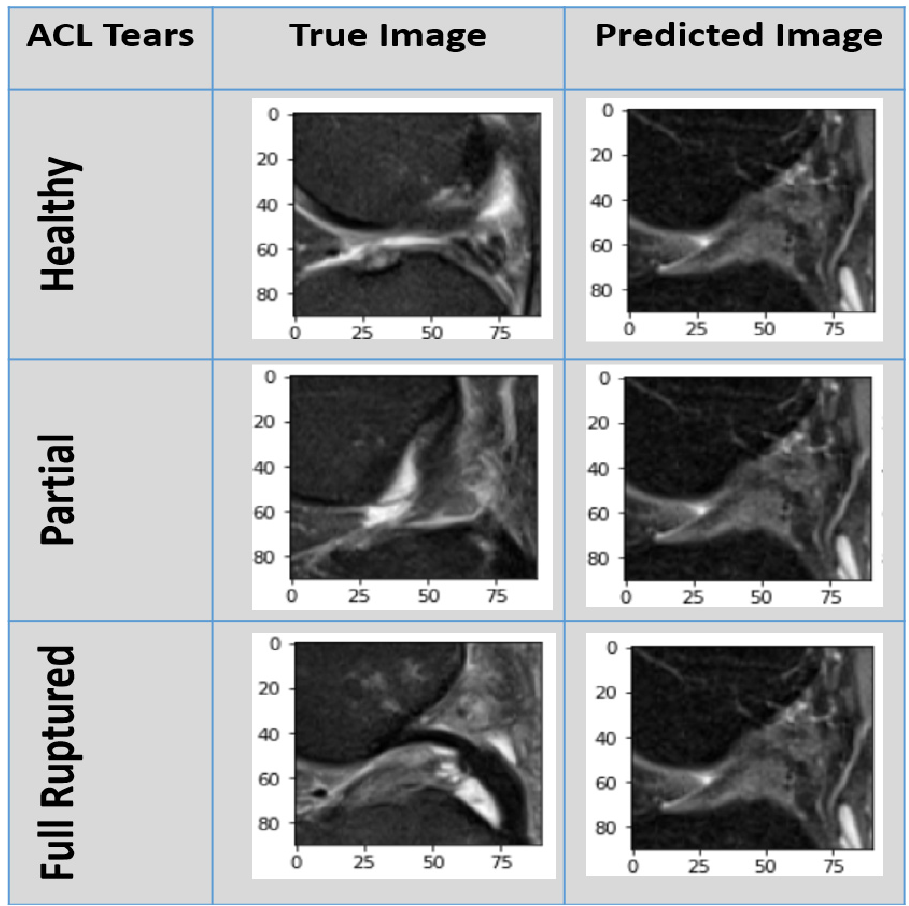
Figure 10. Our model predicted results against true images of healthy, partially ruptured, and fully ruptured ACLs.